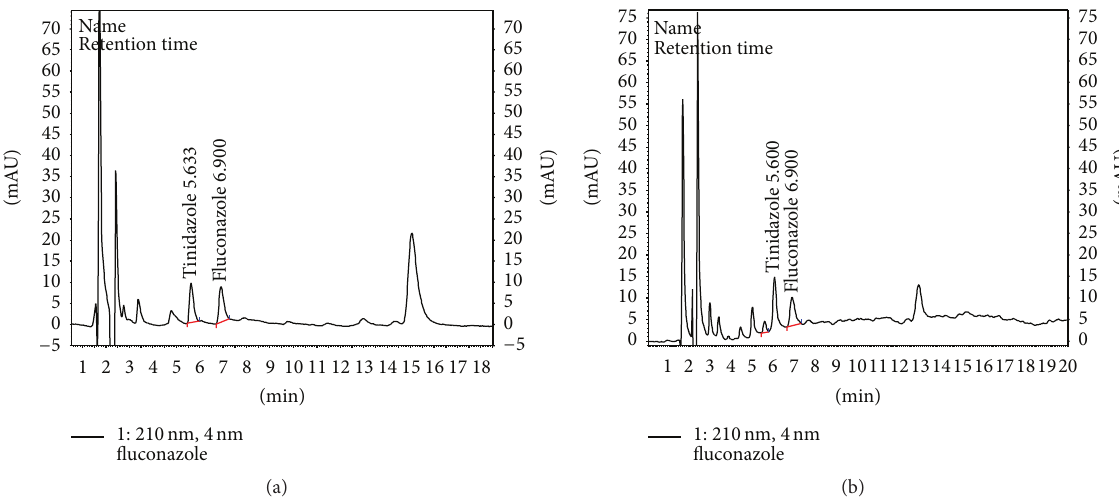
Figure 2: Typical chromatogram of IS and FLC (250 ng/mL) from extracted samples of blank C. albicans (a). Chromatographic separation of IS and FLC in C. albicans ATCC-10231 samples long-term cultivated in the presence of FLC.